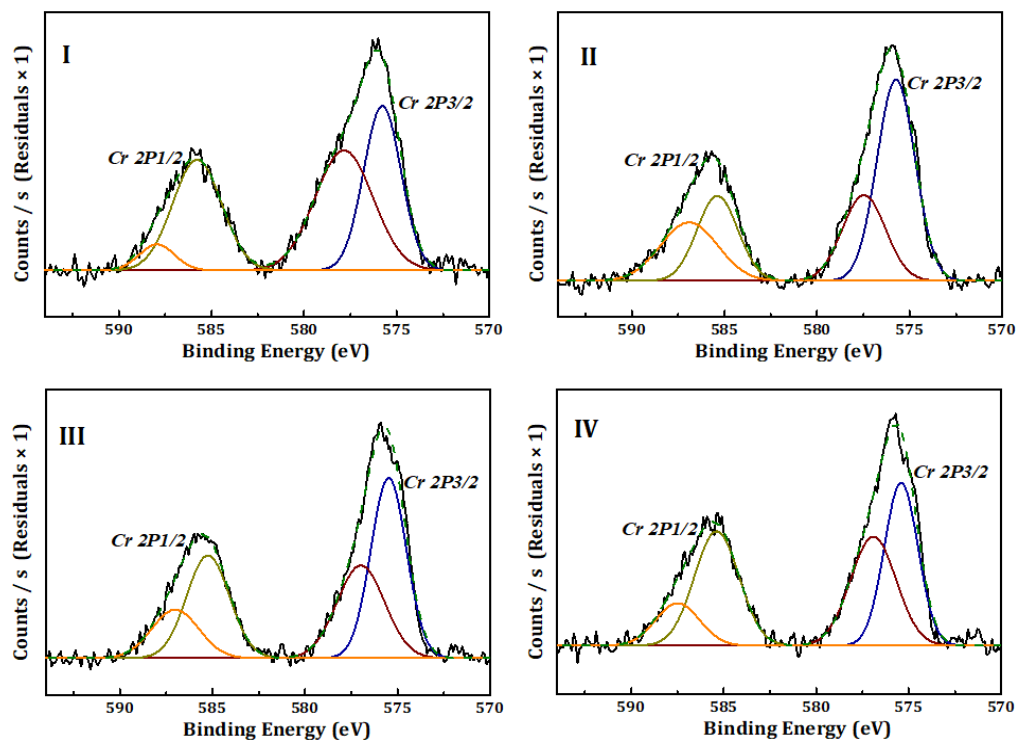
Figure 4. Cr2p XPS spectrum of Cr(8) / MCM-41 ( I ) and Cr(8) / Ti(x)–Si composite prepared with varying titanium loading, where x = 2.2( II ), 5.3( III ) and 9.2( IV ) wt %.